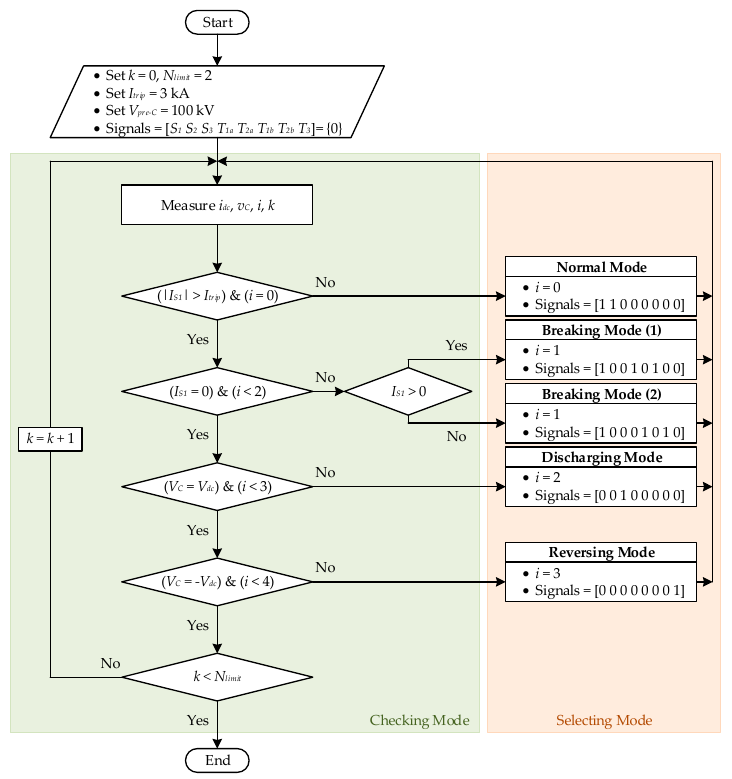
Figure 6. Flowchart of the switching control algorithm for the proposed HCB topology.